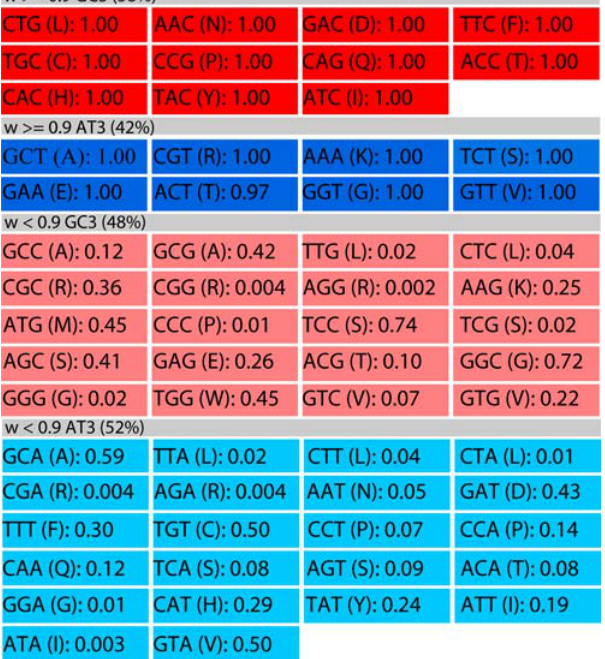
Figure 4. E.coli codon usage master table. The table of 61 codons along with their associated w -values is shown for E. coli . The w -value of each codon reflects its frequency in highly transcribed E. coli genes (see main text). The Table 1 is divided into four regions: codons with high CAI (w $ 0.9) ending in G or C (dark red); codons with high CAI ending in A or T (dark blue); codons with low CAI ( w , 0.9) ending in G or C (light red); codons with low CAI ending in A or T (light blue). As the table shows, there is a slight bias for GC3 in the high-CAI codons (58%), and slight bias away from GC3 in the low-CAI codons (48%).